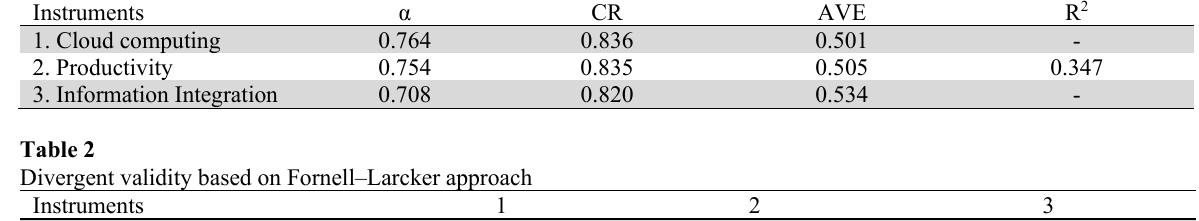
Reliability, convergent validity Instruments